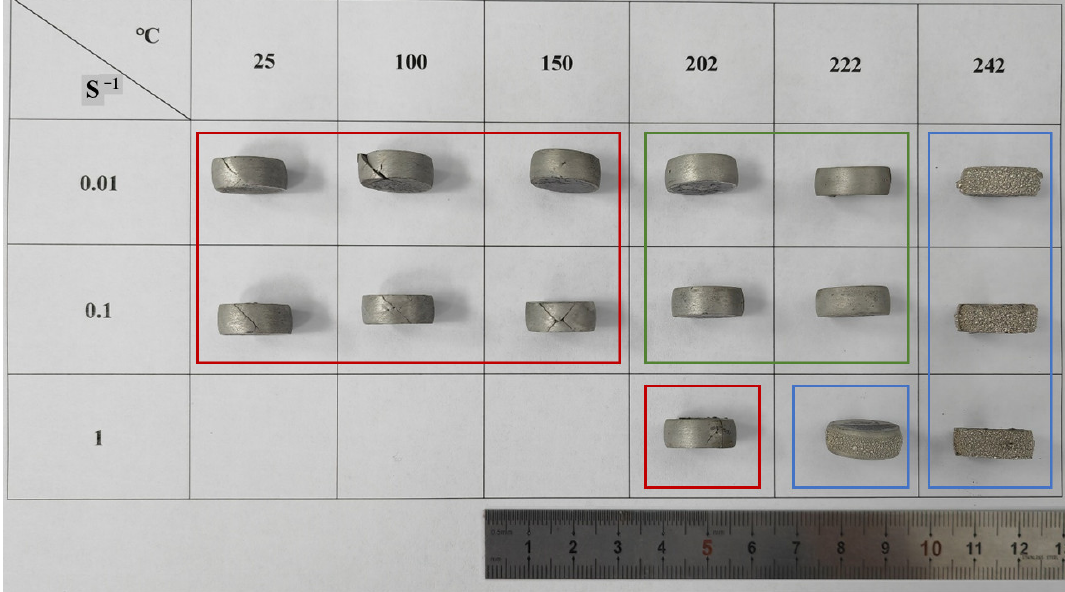
Figure 7. Photos of the alloy specimen after hot compression tests.